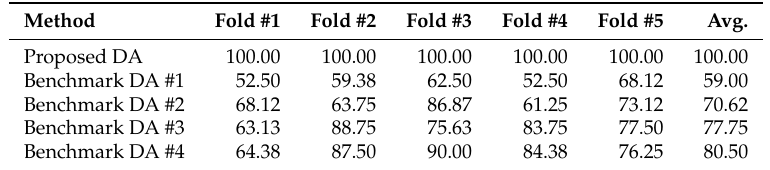
Table 6. Performance comparison between the proposed and benchmark data augmentation methods.